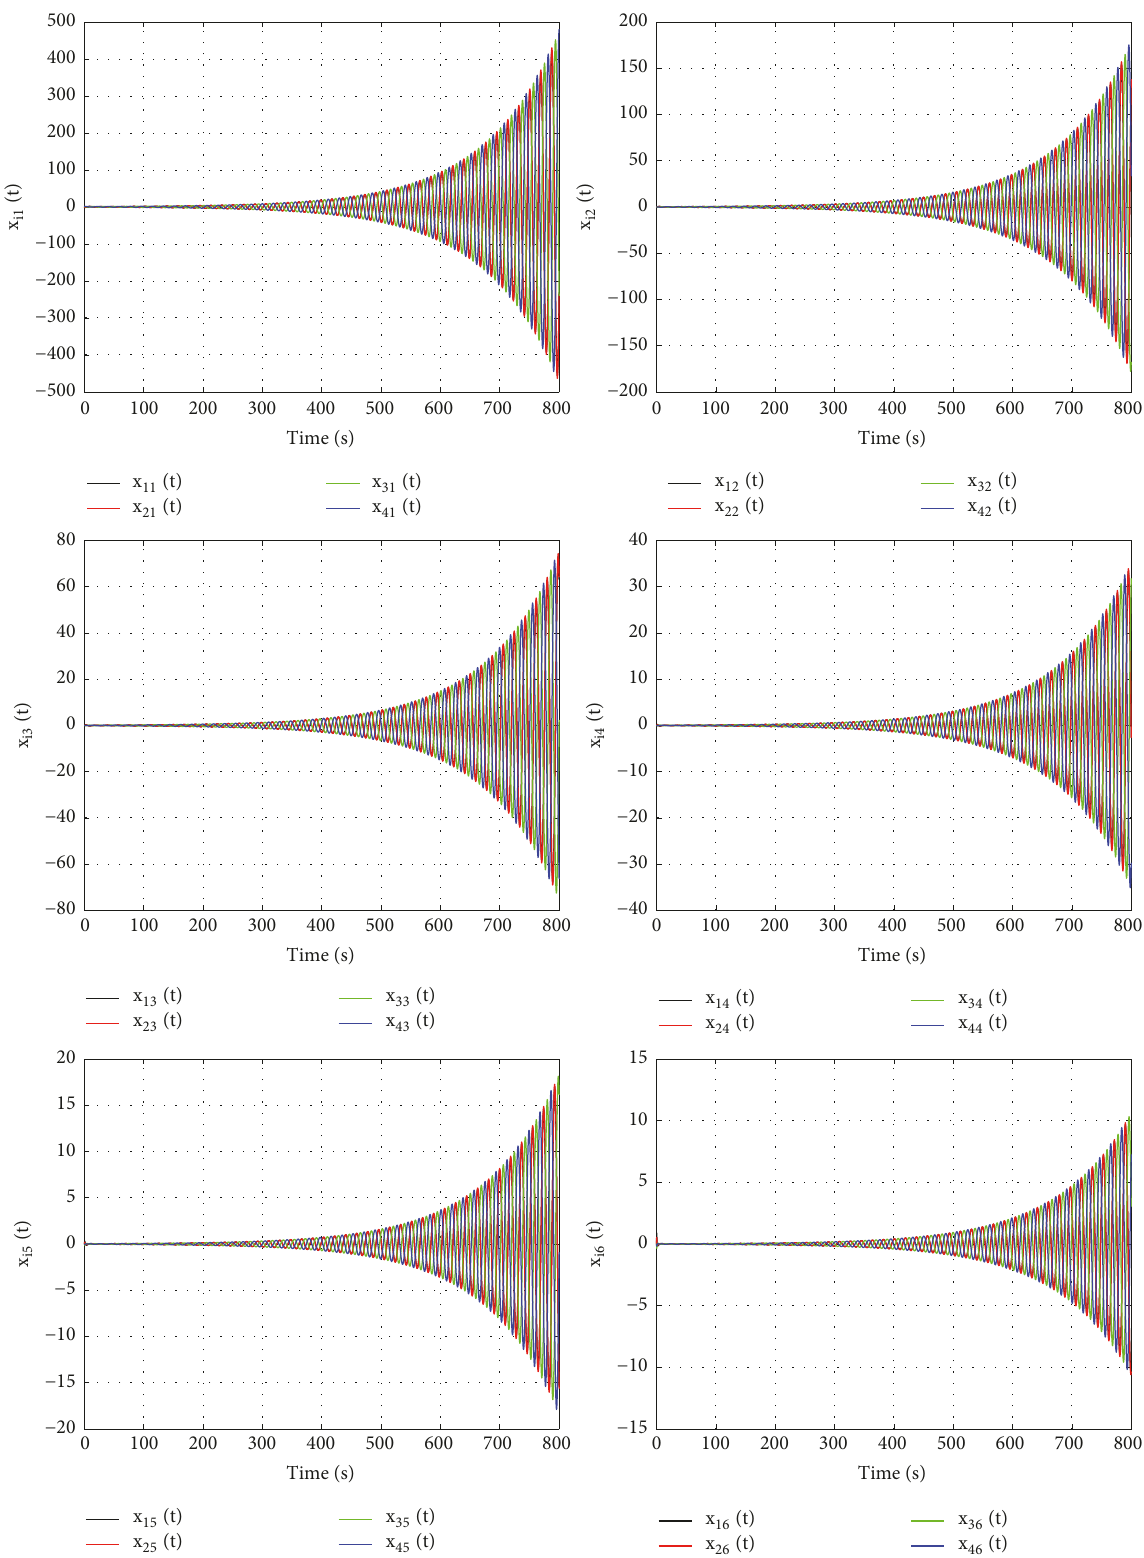
Figure 14: The trajectoriesof all agents’statesinthe FOMASwith sextupleintegraland asymmetric time-delayswhenall 𝜏 𝑚 > 𝜏 inExample